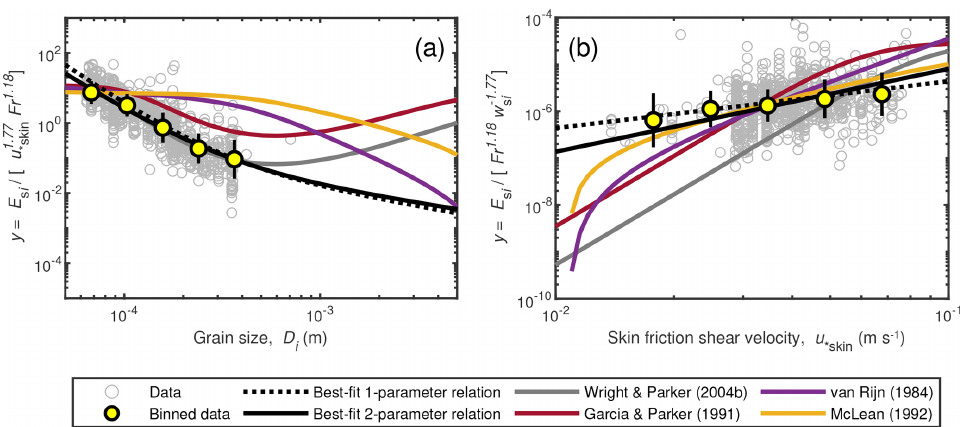
Figure 10. Entrainment parameter, E s i , normalized to isolate the effect of (a) grain size and (b) skin-friction shear velocity to check for spurious correlation. Yellow filled symbols are the geometric mean, and the error bars indicate the geometric standard deviation within each bin. The best-fit models are Eqs. (24) and (25).